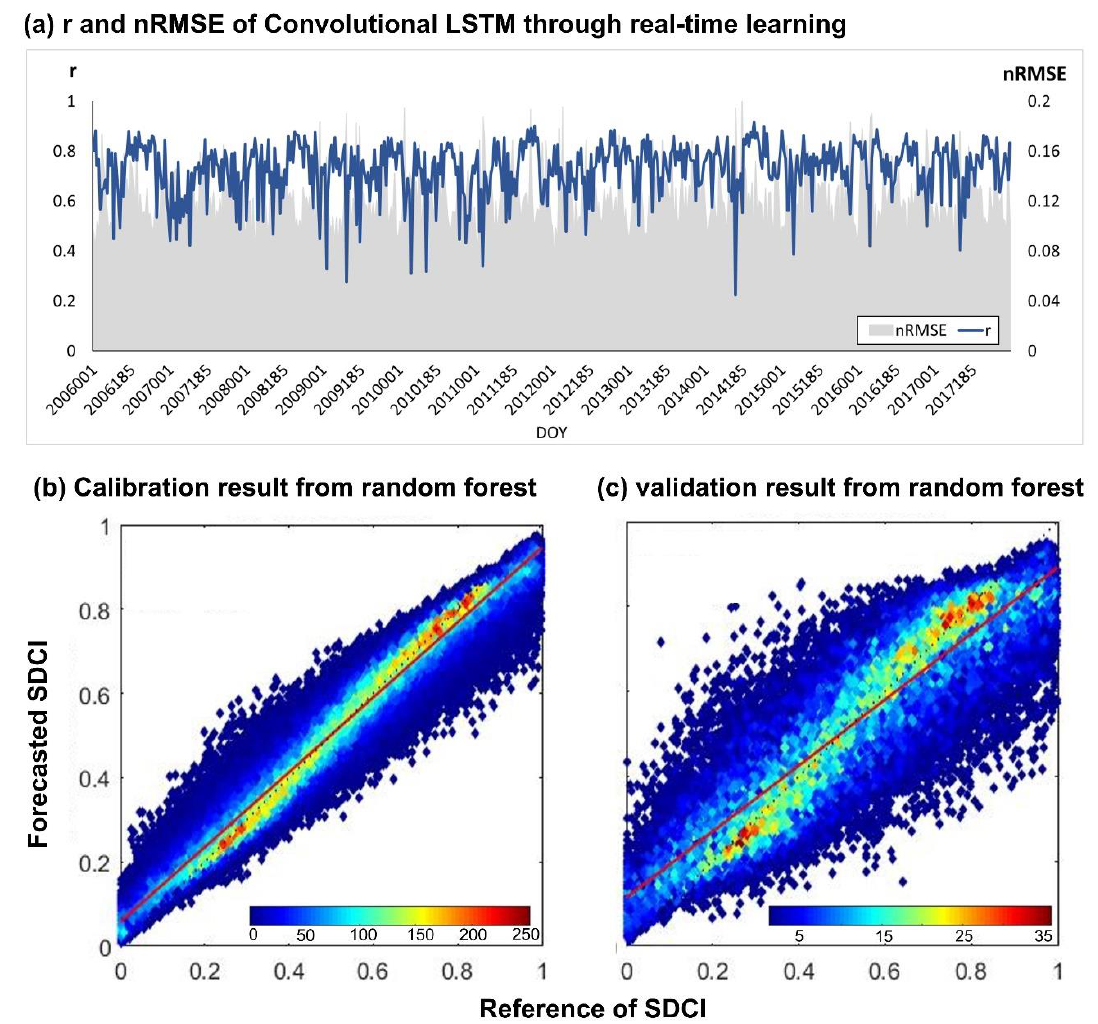
Figure 4. Results of step1 and step2 using SDCI. ( a ) r (blue line) and RMSE (gray shading) through the real-time training of convolutional long short term memory (ConvLSTM) from 2006 to 2017, ( b ) calibration results from random forest (RF) and ( c ) validation results from random forest (RF).